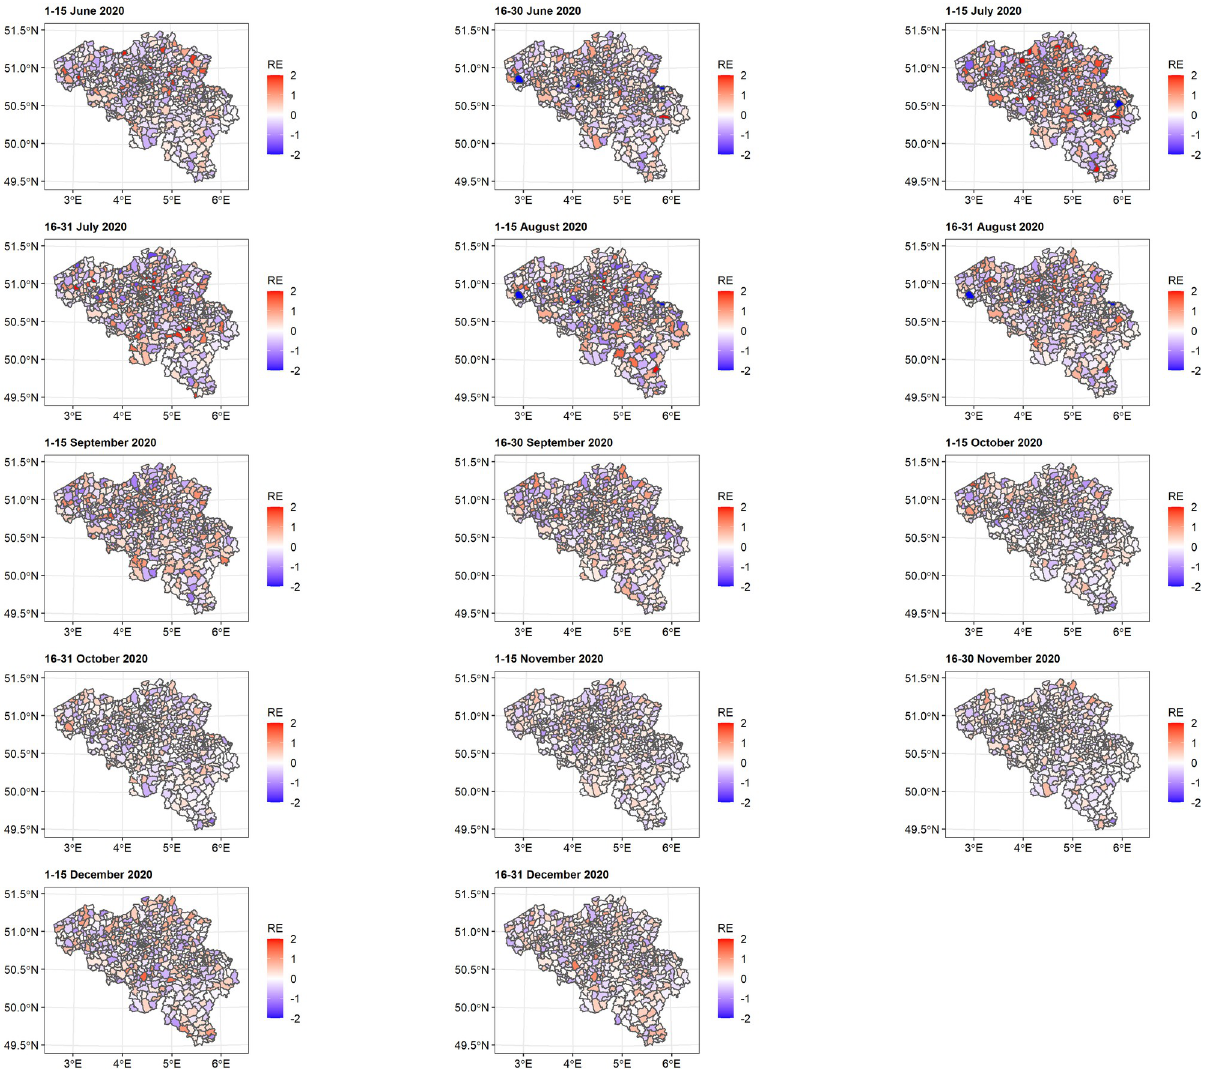
Fig 9. Distribution of spatial random effect at municipality level. RE = random